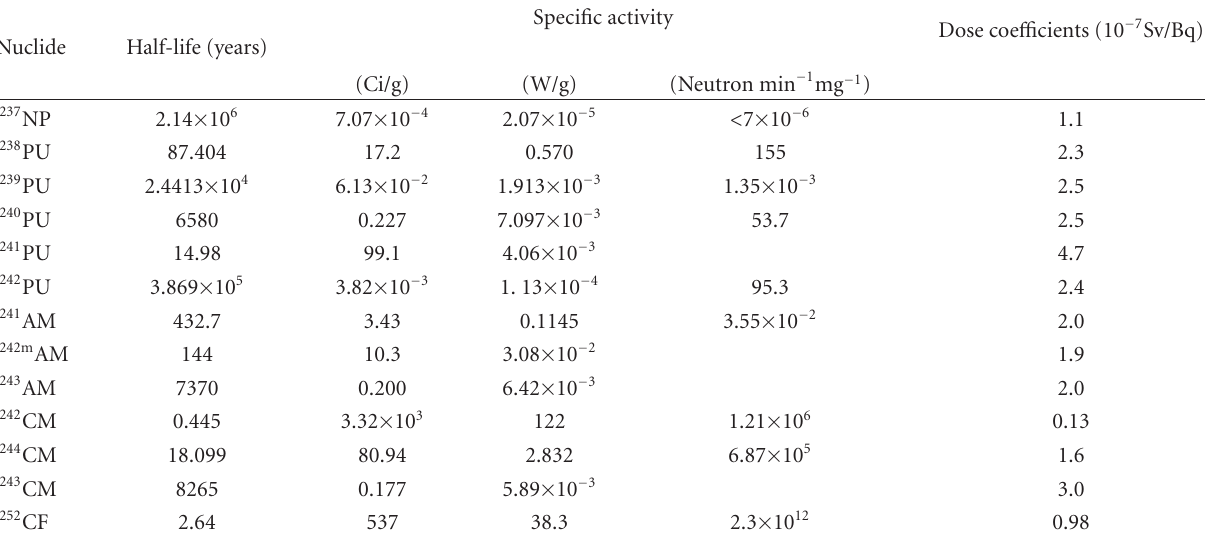
Table 2: Decay power and other properties of some actinide nuclides [1].